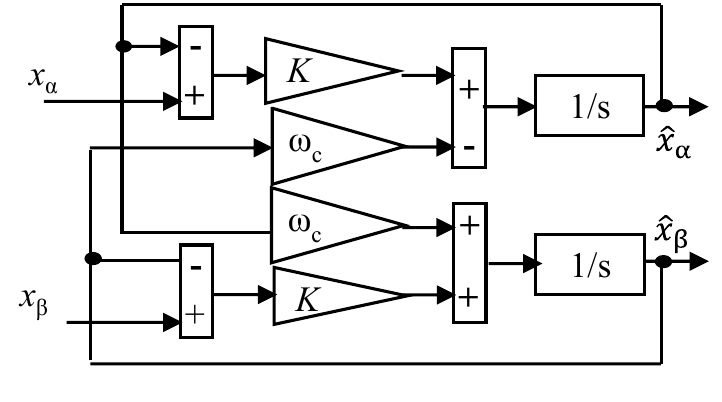
Figure 6. Block diagram of HSF filter.